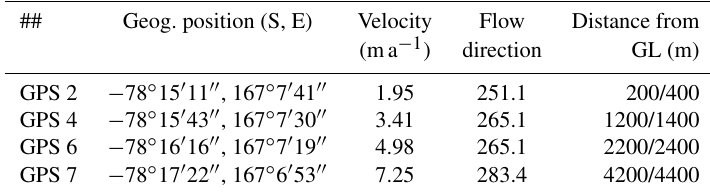
Table 1. GPS positions with average ice shelf displacements over the fieldwork period and their estimated distance from the grounding line (GL) before and after application of strain correction (see text). The flow direction is measured in degrees from north.